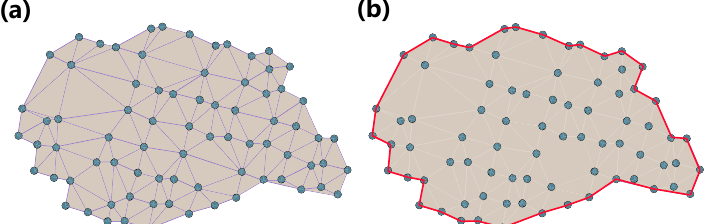
Figure 6. Triangulation generation and boundary extraction of dense point cloud based on pro- posed algorithm: ( a ) represents triangular mesh generation; ( b ) represents boundary extraction.